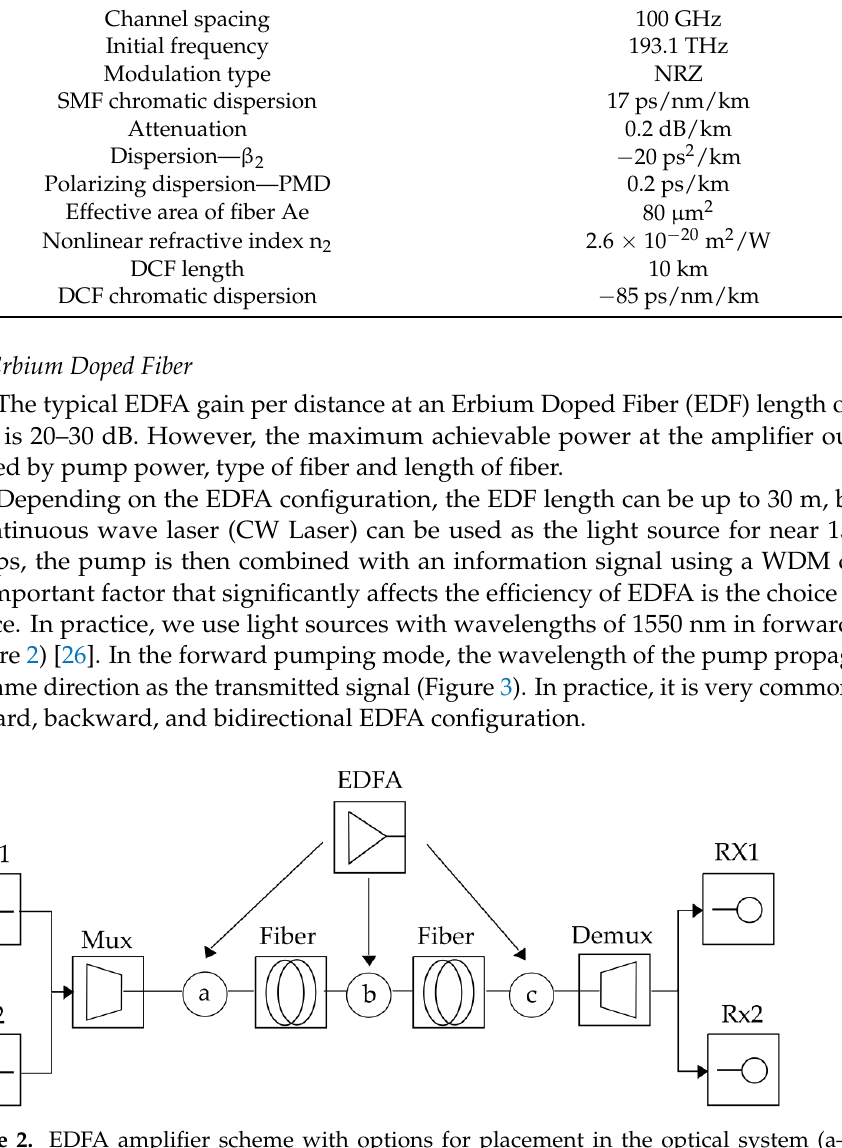
Figure 2. EDFA amplifier scheme with options for placement in the optical system (a—power amplifier, b—in-line amplifier, c—preamplifier).